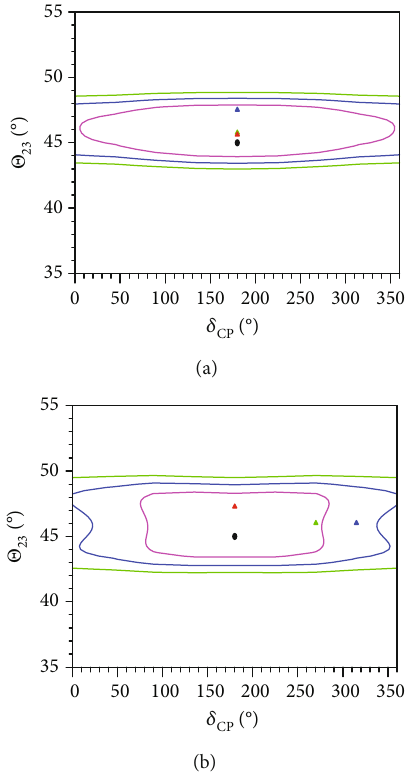
, δ Figure 3: Con fi dence regions in the ( θ 23 CP ) plane, obtained by using the migration matrices of pure QE and QE -like events are shown in (a) and by using the migration matrices of pure QE + RES + DIS and QE + RES + DIS -like events are shown in (b). The circle ( α = 1 ) shows the true value of the oscillation parameters while the blue( α = 0 ), red( α = 0 : 3 ), and green( α = 0 : 5 ) triangles represent the best fi t